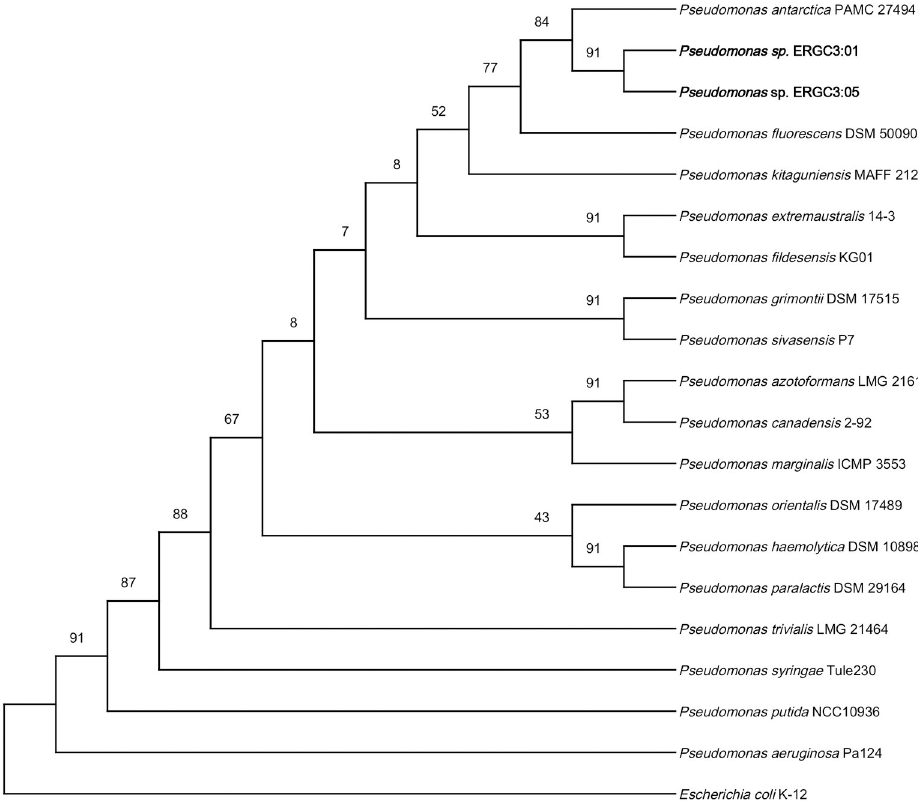
Fig 6. Phylogenomic tree of representative Pseudomonas strains based on 91 core genes using the UBCG tool. The tool extracted 91 core genes from the genomes of nearest neighbors and prepared the tree using RaxML. Support values are calculated from 1000 rapid bootstrap replicates (BT) and BT values are indicated at branching points. Our test strains are marked in bold, E . coli K12 MG1655 was used as the outgroup organism.